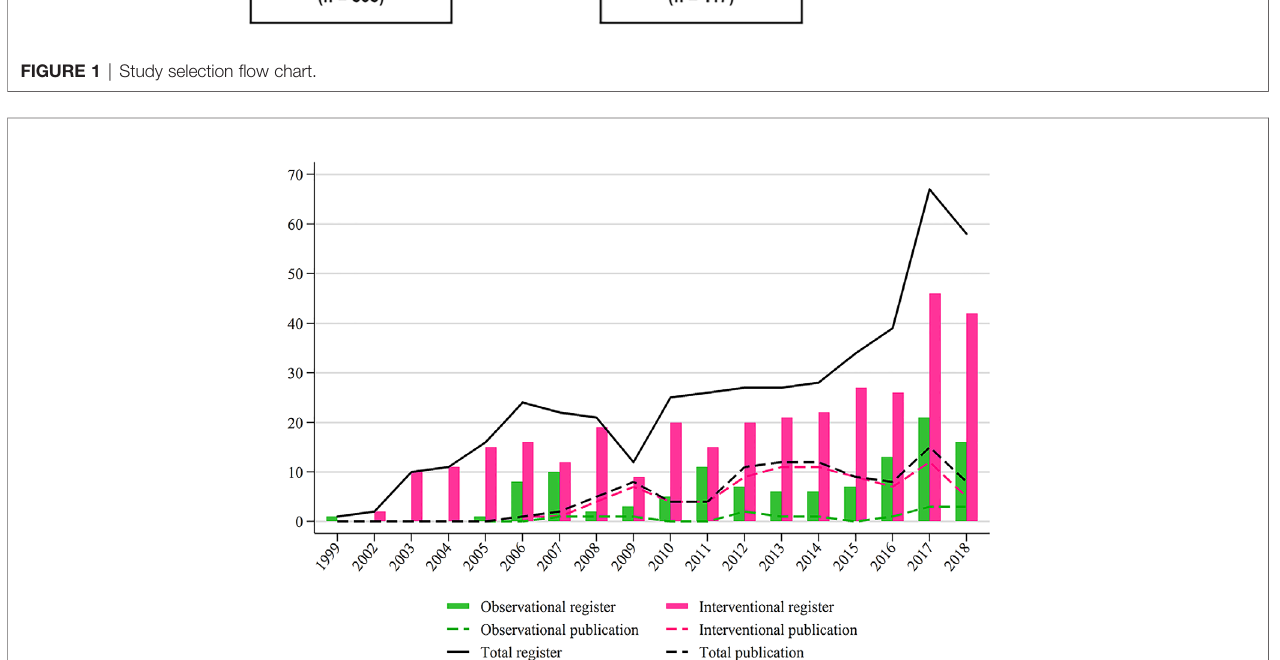
FIGURE 2 | Study distributions of register and publication for observational and interventional studies according to the registered or published year.